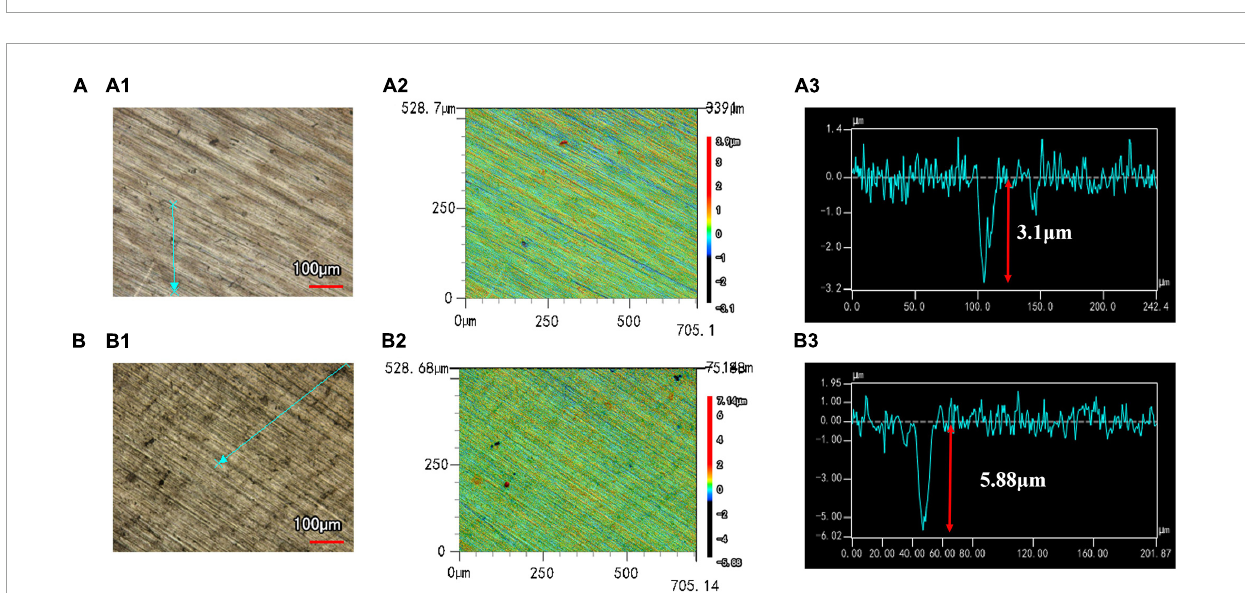
FIGURE3 Corrosion morphology and the maximum pitting depth of B30 copper–nickel alloy after immersion in different media for 21 days: (A) abiotic medium; (B) P. aeruginosa